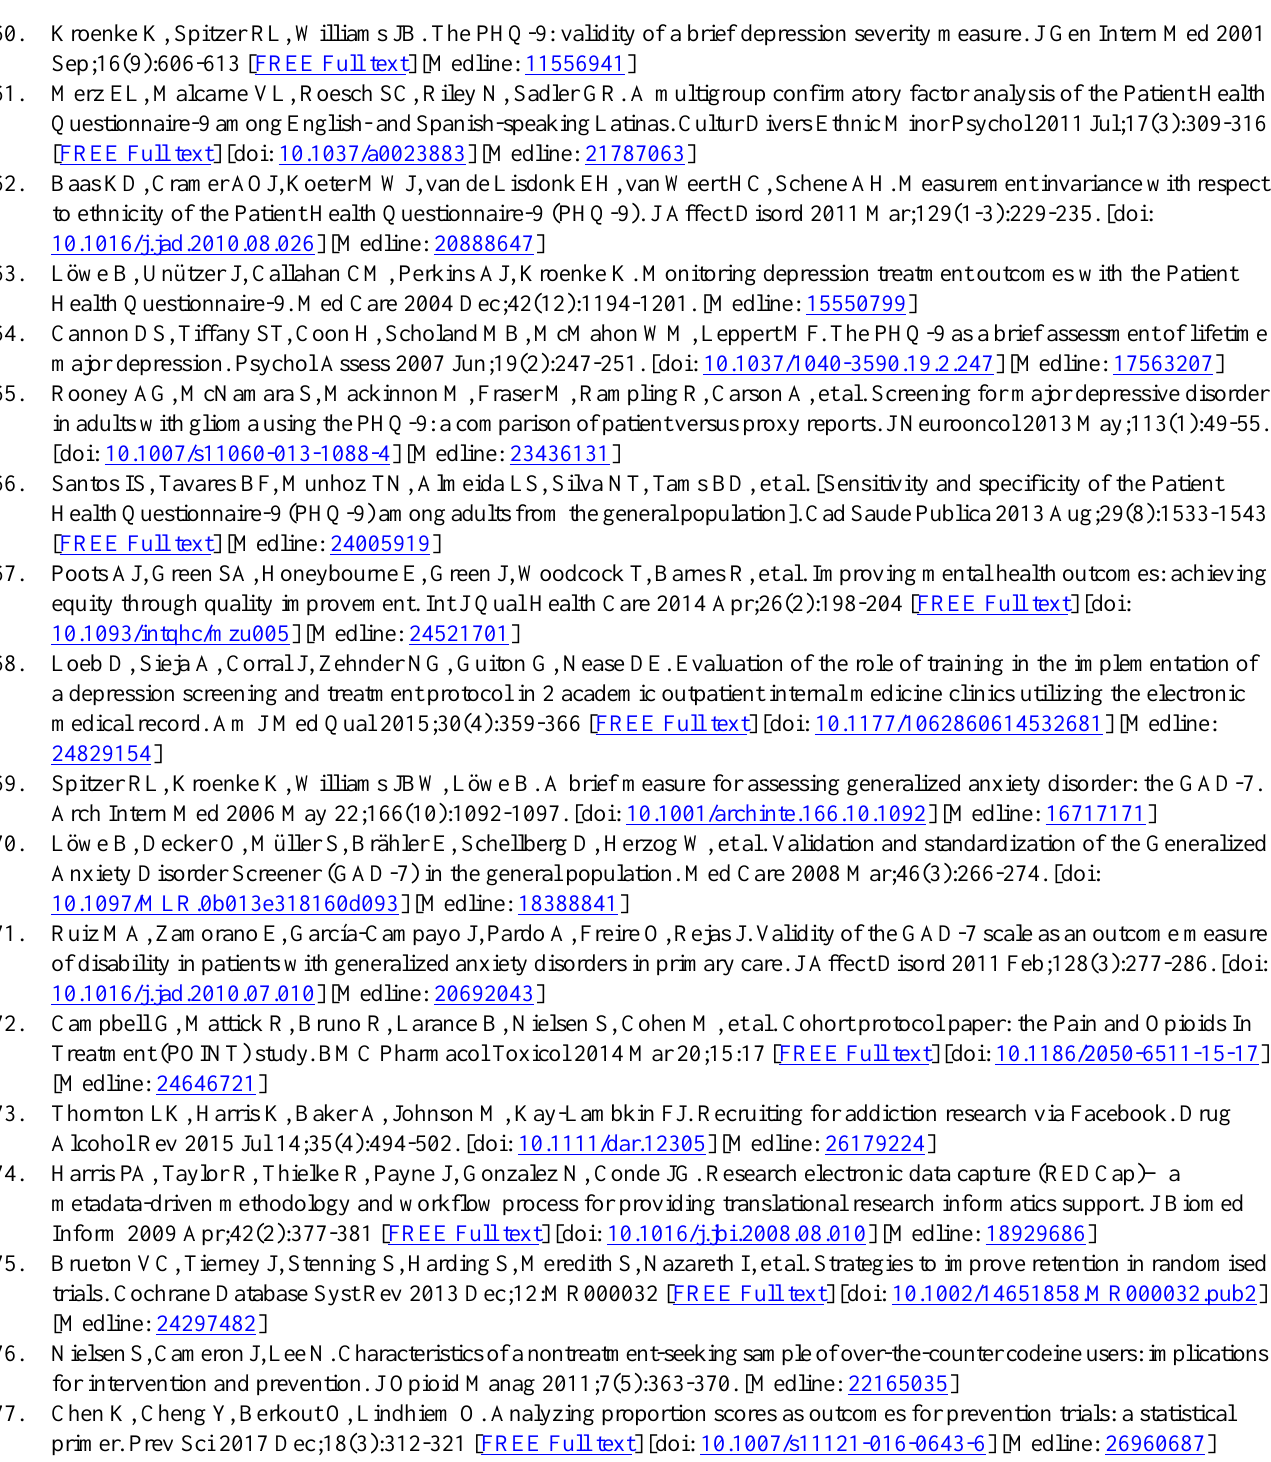
PEG: Pain Intensity, Enjoyment of Life, and General Activity Assessment Tool